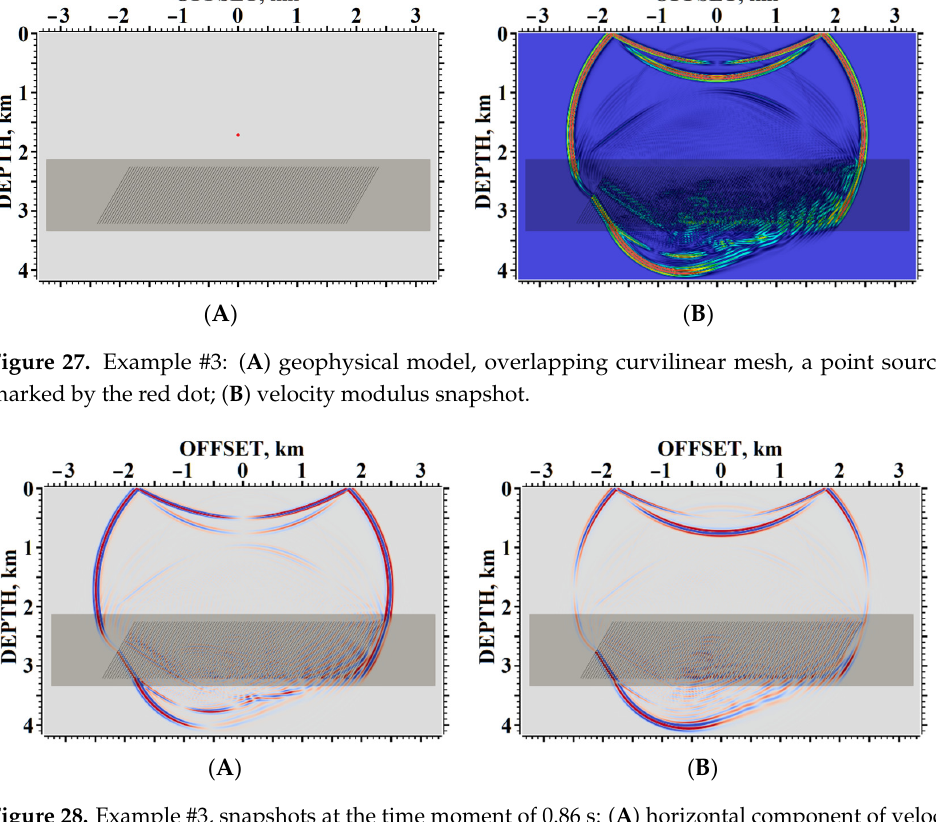
Figure 29. Example #4: ( A ) scales of elastic parameters; ( B ) geophysical model, overlapping curvi- linear meshes, the point source is marked by the red dot; ( C ) velocity modulus snapshot.